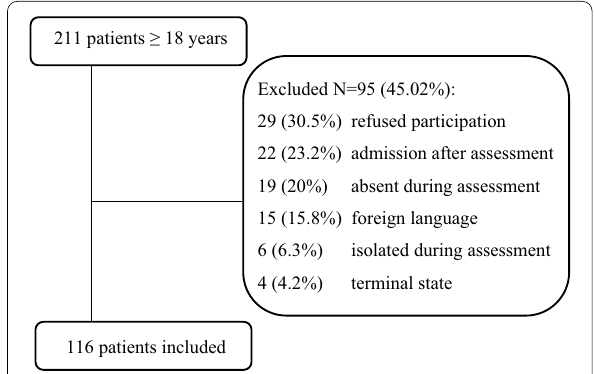
Fig. 2 Flow chart of patient inclusion and